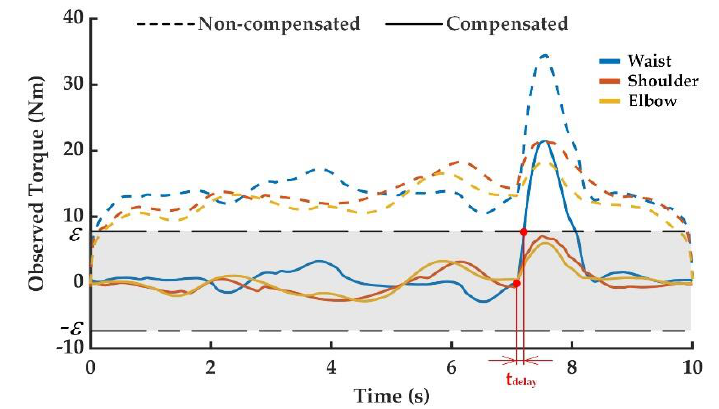
Figure 5. External torque observation in the first collision experiment.